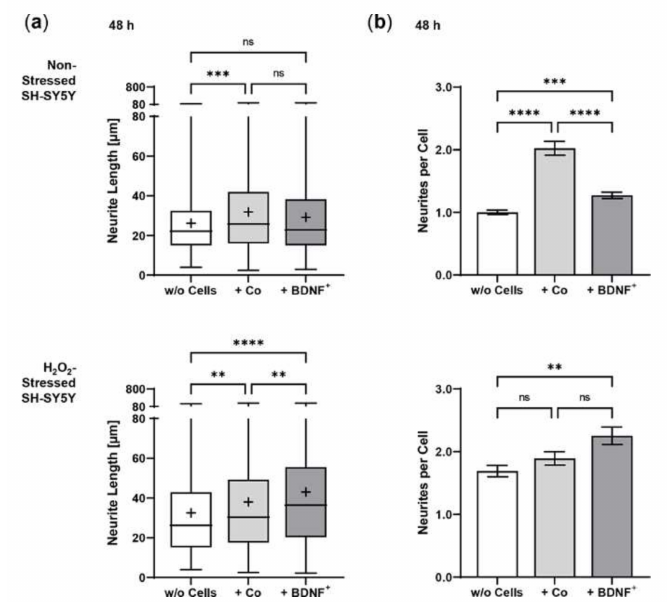
Figure 9. BDNF-mediated neurite outgrowth in non-stressed and H 2 O 2 -stressed SY-SY5Y cells after co-cultivation with primary hRPE cells. Co-cultures were performed with BDNF-transfected cells (BDNF + , transfected with 0.03 µ g SB100X transposase and 0.47 µ g BDNF transposon plasmid) from two donors (age: 65.5 ± 6.36 years, gender: one male and one female, time postmortem: 34.6 ± 18.2 h, cultivation time before transfection: 67.5 ± 0.71 days). Co-cultures were started 25 days after transfection. In each experiment ( n = 2), five images were analyzed for cultures with non-stressed SH-SY5Y cells and seven to ten images for cultures with H 2 O 2 -stressed SH-SY5Y cells. Neurite length was determined after 48 h by converting pixels into µ m (one pixel = 0.1 µ m), excluding outgrowths of less than 2 µ m. ( a ) Neurite lengths in the different cultures after 48 h. Non-stressed SH-SY5Y cells co-cultivated with non-transfected cells (Co) and BDNF + cells showed increased neurite lengths compared to SH-SY5Y cells alone (w/o Cells) (*** p = 0.0001 for Co, not significant for BDNF + ). Note that neurite lengths were more increased in Co co-cultures than in BDNF + co-cultures, although not significantly. H 2 O 2 -stressed SH-SY5Y cells co-cultivated with Co and BDNF + cells showed significantly increased neurite lengths compared to SH-SY5Y alone (** p = 0.0023, **** p < 0.0001). Furthermore, BDNF + co-cultures showed significantly increased neurite lengths compared to Co co-cultures (** p = 0.0053, Kruskal-Wallis test with Dunn’s multiple comparisons test). Number of values: 690–815 for non-stressed SH-SY5Y, 580–613 for H 2 O 2 -stressed SH-SY5Y. Data are presented as box and whisker plots (whiskers: minimum to maximum, mean values indicated by +). ( b ) Neurites per cell in the different cultures. For non-stressed SH-SY5Y cells, significant differences were observed for all comparisons (*** p = 0.0005, **** p < 0.0001); however, the highest number of neurites per cell was observed for Co co-cultures. For H 2 O 2 -stressed SH-SY5Y cells, Co and BDNF + co-cultures showed increased numbers of neurites per cell compared to SH-SY5Y alone (not significant for Co, ** p = 0.0013 for BDNF + , Ordinary one-way ANOVA with Tukey’s multiple comparisons test). Number of values: 341–781 for non-stressed SH-SY5Y, 259–343 for H 2 O 2 -stressed SH-SY5Y. Data are presented as mean ±